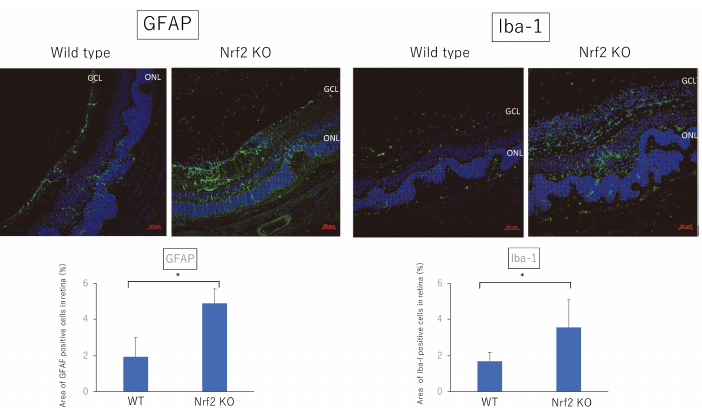
Figure 5. Immunohistochemical analysis of GFAP and Iba-1 positive cells in posterior segment of EAU-induced WT mice and Nrf2 KO mice. Wild type and Nrf2 knockout mice were immunized with IRBP peptide and immunohistochemical analysis was performed using eyes enucleated on day 21 after immunization. Green: GFAP and Iba-1 positive cells. Blue: Nuclei. Scale bar: 50 μm. GCL: ganglion cell layer, ONL: outer nuclear layer. Either eye per mouse was used for immunohistochem- ical analysis. The mean ± standard deviation for each group ( n = 3–6 mice per group) is shown. The relative area (%) of GFAP positive cells or Iba-1 positive cells in a given area of retina was calculated using binary images. Asterisk indicates p < 0.05 versus WT mice. Statistical analysis was performed according to Student’s t test.